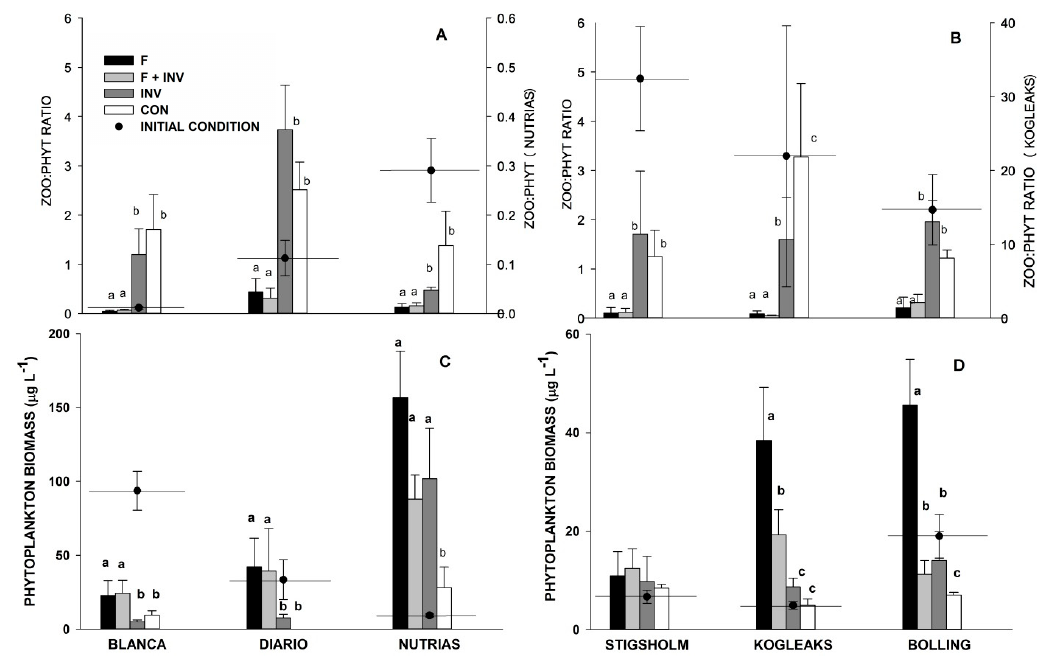
Figure 3. Effects of treatments on potential zooplankton grazing pressure ( A , B ) and phytoplankton biomass ( C , D ) in subtropical ( left ) and temperate ( right ) lakes. Dotted and horizontal lines represent initial values (just before treatment assignment and 15 days after fish exclusion), while columns depict final values (49 days after fish and invertebrate addition). F (fish); F + INV (fish + predatory macroinvertebrates) and INV (predatory macroinvertebrates). Error bars represent ±1 standard error. Please note the different scales on the y -axis. Letters indicate groups according to Tukey’s post hoc tests when ANOVA tests were significant.